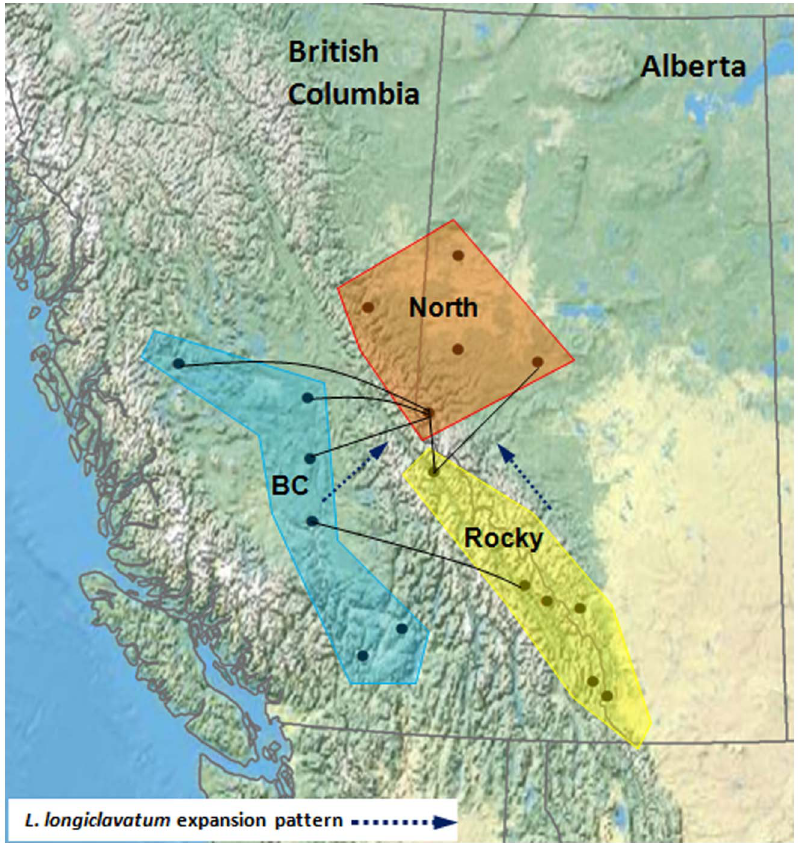
Figure 3. Diagram showing potential gene flow among three clusters and the movement and demographic expansion pattern of L. longiclavatum inferred from DIYABC . Solid lines indicate there is no significant difference between the F ST values of two locations, suggesting gene flow between them (only connections among clusters are shown; refer to Table S4 for F ST differentiation/connections among locations within each cluster).